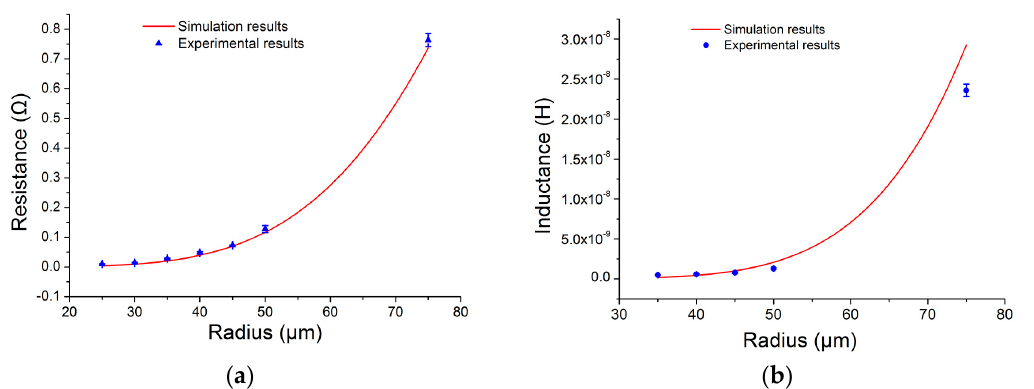
Figure 6. Comparison of the experimental results and the simulation results: ( a ) Detection results of the copper particles with diameters ranging from 48 μ m to 150 μ m; ( b ) Detection results of the copper particles with diameters ranging from 70 μ m to 150 μ m.